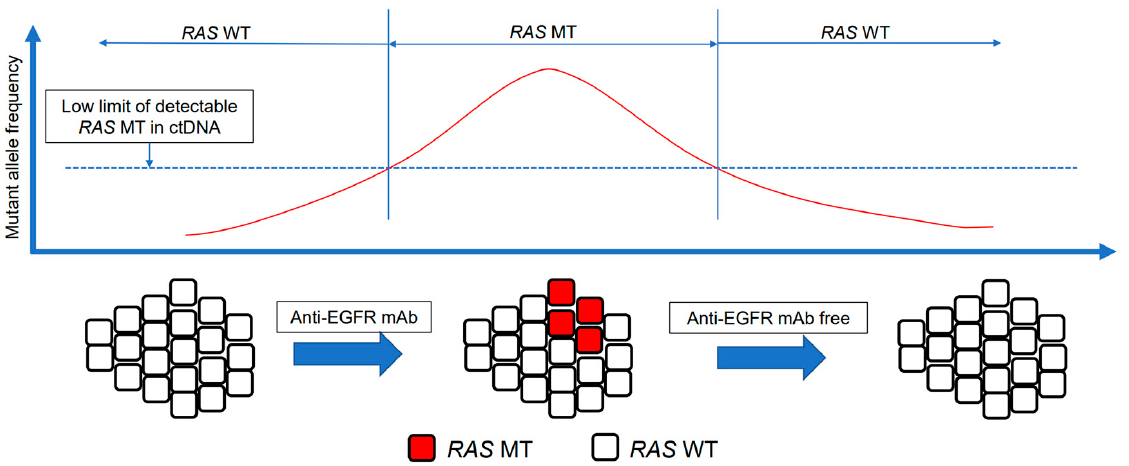
Figure 1. Concept of anti-EGFR mAb rechallenge. The intratumor heterogeneity of mCRC and the dynamism of clonal evolution under the selection pressure of treatment. The emergence of RAS mutations in tumors is a well-recognized mechanism of acquiring resistance to anti-EGFR mAbs. RAS mutations are sub-clonal mutations with a low allele frequency. After withdrawal of anti-EGFR mAbs, chemotherapy restores anti-EGFR mAb sensitivity. RAS MT clones are not detected, and EGFR-sensitive clones are predominant. mAb, monoclonal antibody; EGFR, epidermal growth factor receptor; ctDNA, circulating tumor DNA; MT, mutant; WT,